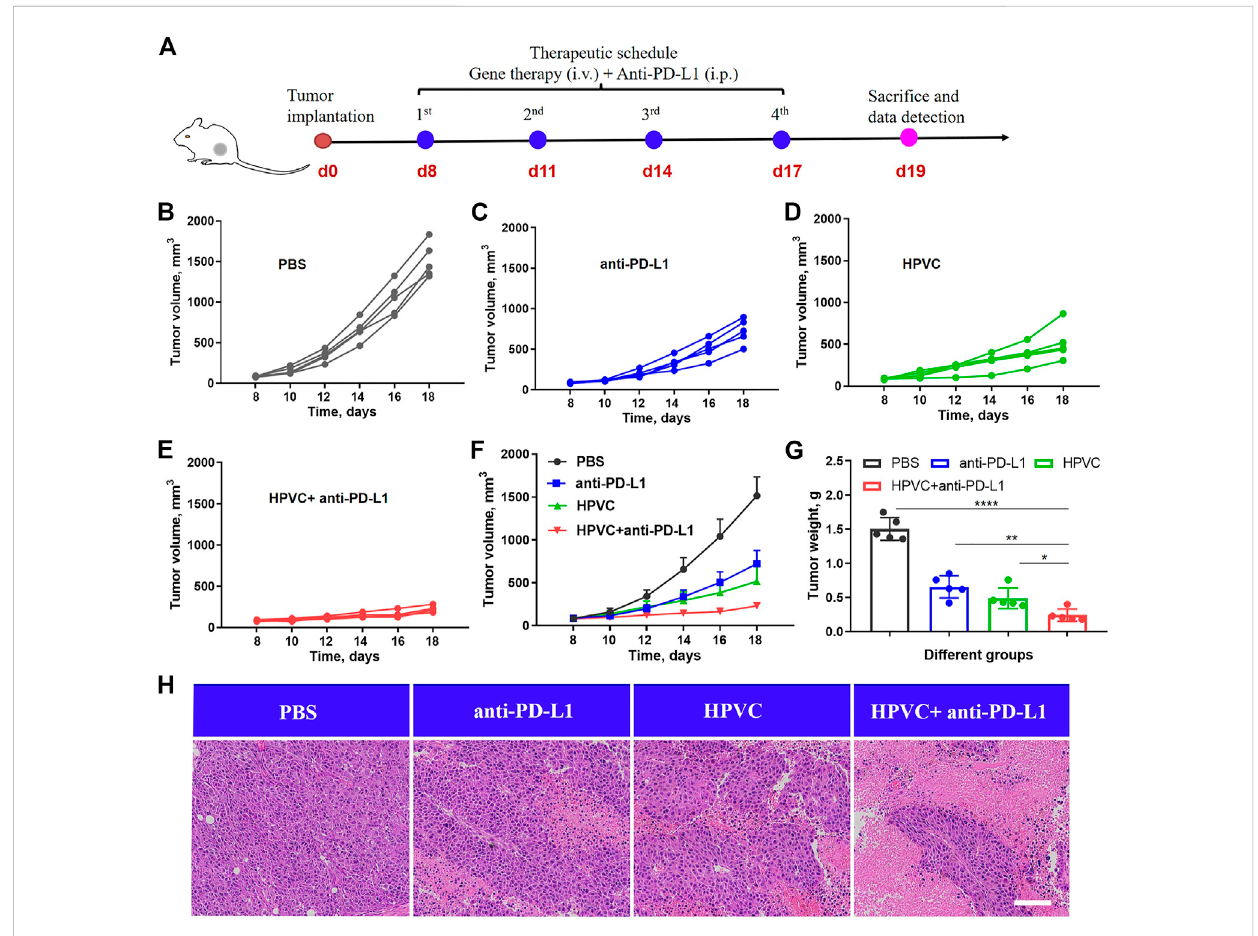
FIGURE 5 Combined antitumor therapy by HPVC and anti-PD-L1 antibody. (A) Schematic illustration of antitumor therapy in CT26 tumor-bearing mice by combined therapy. Individual tumor growth curves of mice in (B) PBS, (C) anti-PD-L1, (D) HPVC and (E) anti-PD-L1+HPVC. (F) Average tumor growth curvesofmiceindifferenttreatmentgroups(n=5). (G) Averagetumorweightindifferentgroups(n=5). (H) H&Ehistologicalanalysisoftumortissues on day 19. Scale bar = 200 μ m * p < 0.05, ** p < 0.01, **** p <